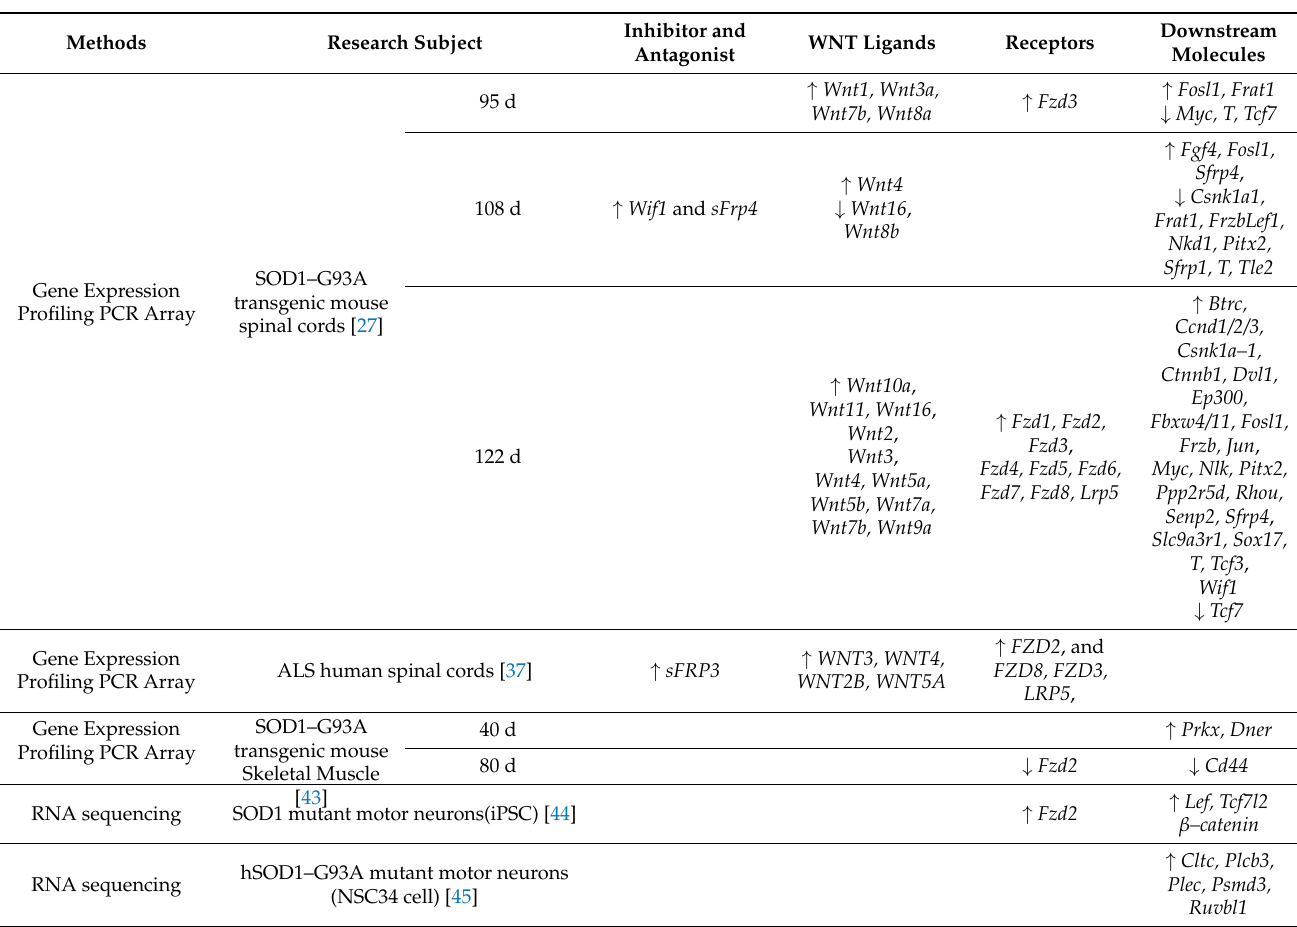
Table 1. Changes in levels of WNT signaling components in human ALS- and SOD1–G93A transgenic mouse and motor neuron.